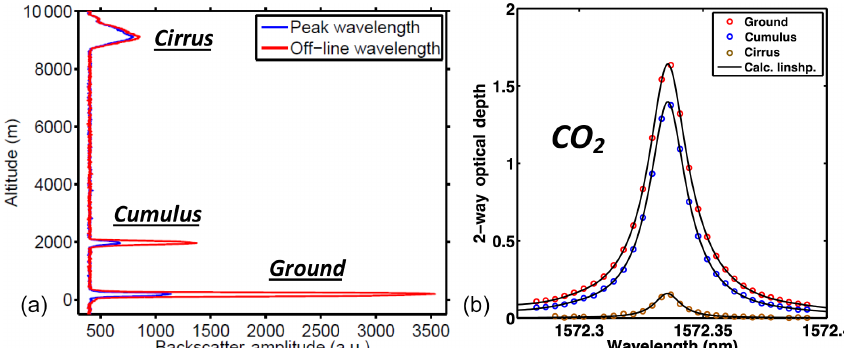
Figure 2. Backscatter profile (a) and CO 2 absorption line shapes (b) in terms of optical depth for laser returns from ground, cumulus clouds and cirrus clouds from a flight altitude of 12km near the West Branch, Iowa, tall-tower site on 10 August 2011. In the left panel, the offline backscatter profile is plotted in red, and the backscatter profile at line center with peak absorption is plotted in blue. Both optical depth and differential optical depth between offline and line center wavelength increase with photon path length or range between aircraft and the scattering surface. Data are averaged over 10s of ground track for both plots. In the right panel the dots are the lidar measurements and the solid lines are the best-fit line shapes from the XCO 2